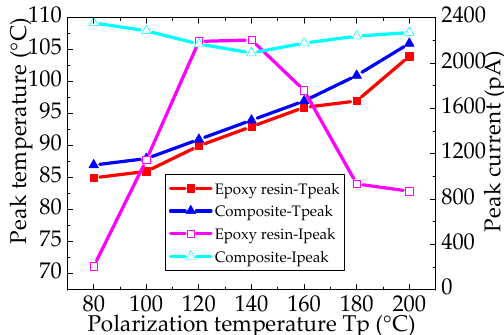
Figure 12. Comparison of α relaxation peak of TSDC spectra.